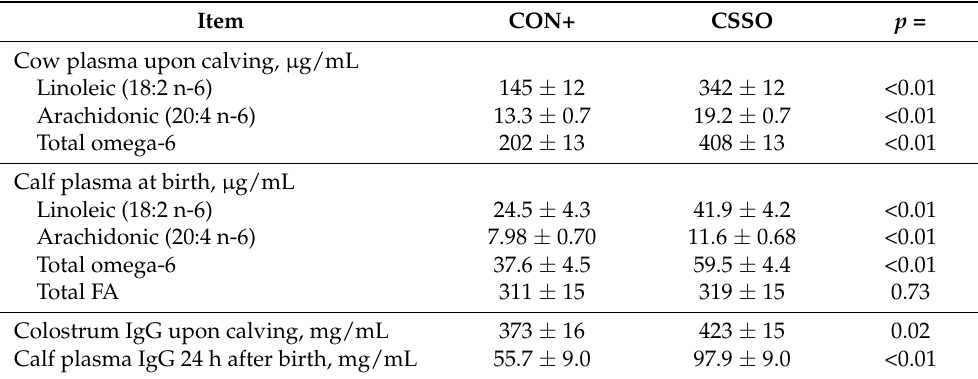
Table 3. Concentrations of fatty acids (FA) and immunoglobulin G (IgG) in cows and their calves upon calving. Cows were supplemented with Ca soaps of soybean oil (CSSO; n = 52) or prilled saturated fat (CON+; n = 52) during the last trimester of gestation. Values reported are least square means ± standard error. Adapted from Brand ã o et al.